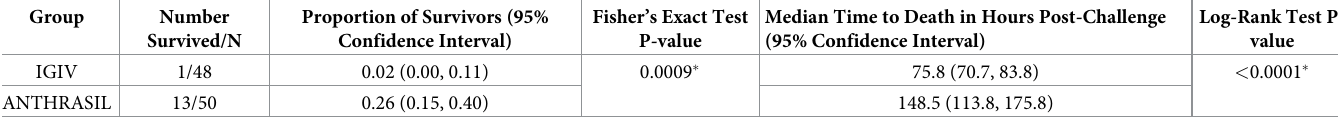
Table 2. Proportion of survivors and median time to death in B . anthracis -infected rabbits treated with IGIV or ANTHRASIL. Group Number Survived/N